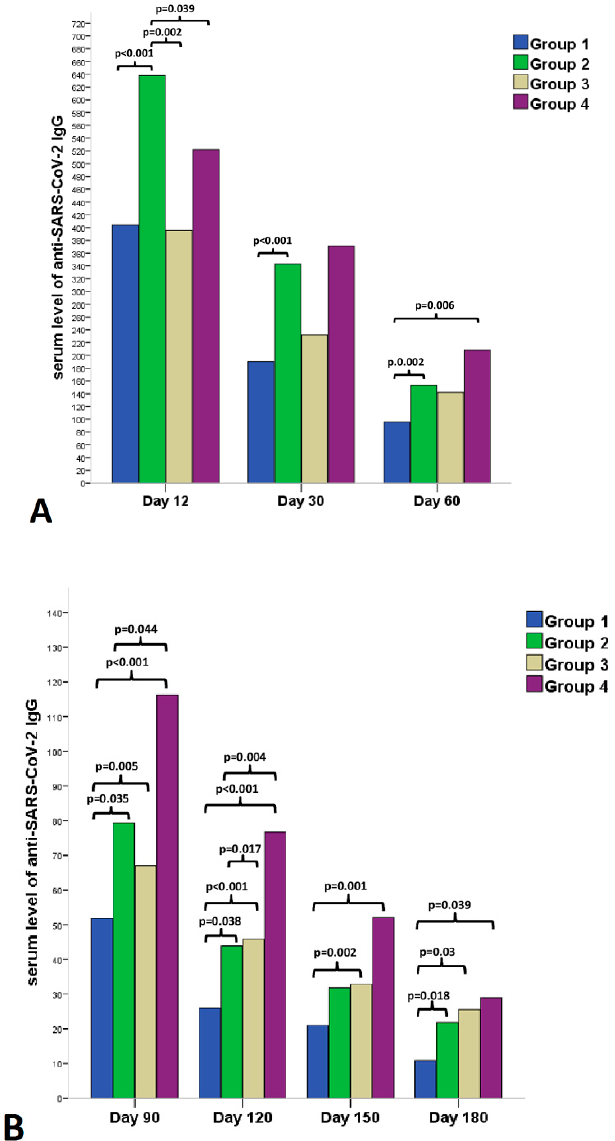
Figure 3. Comparison of serum levels of anti-SARS-CoV-2 IgG at ( A ) 12, 30, 60 and ( B ) 90, 120, 150, 180 days after the 2nd dose of vaccination (BNT162b2 mRNA). Healthcare workers were divided into four study groups: Group 1 = individuals without prior SARS-CoV-2 infection and with no adverse reaction after vaccination; Group 2 = individuals without prior SARS-CoV-2 infection and with at least one adverse reaction after vaccination; Group 3 = individuals with prior SARS-CoV-2 infection and with no adverse reaction after vaccination; Group 4 = those who had prior SARS-CoV-2 infection and at least one adverse reaction after vaccination. Sample size at each follow-up time point is shown in table below.